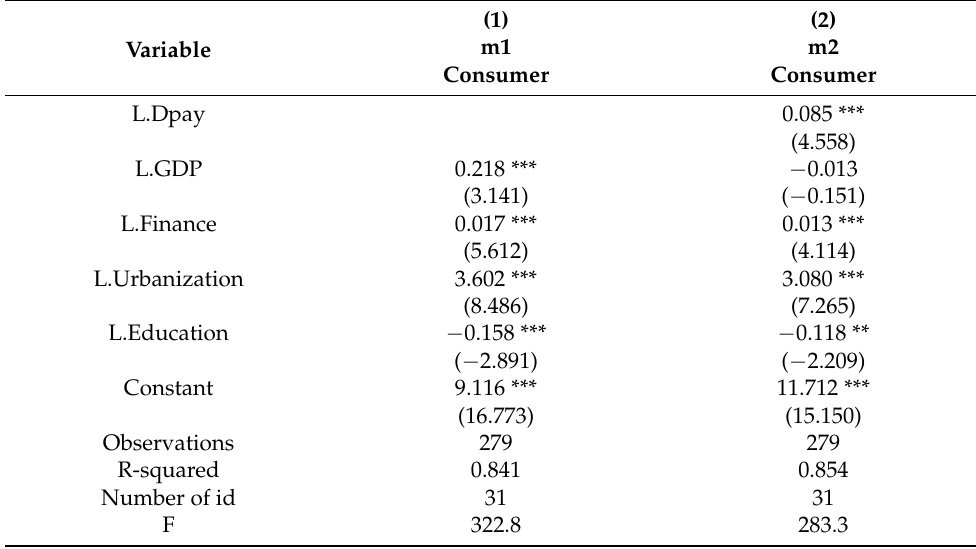
Table 5. Endogeneity test: variable lag regression analysis.